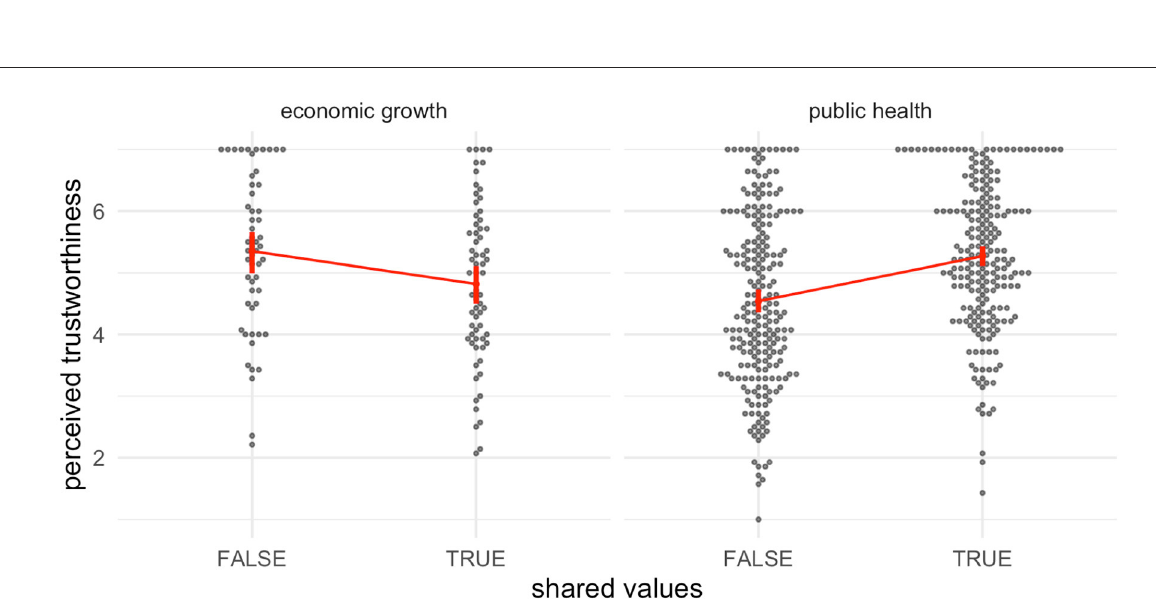
the interaction term) in a regression model creates perfect